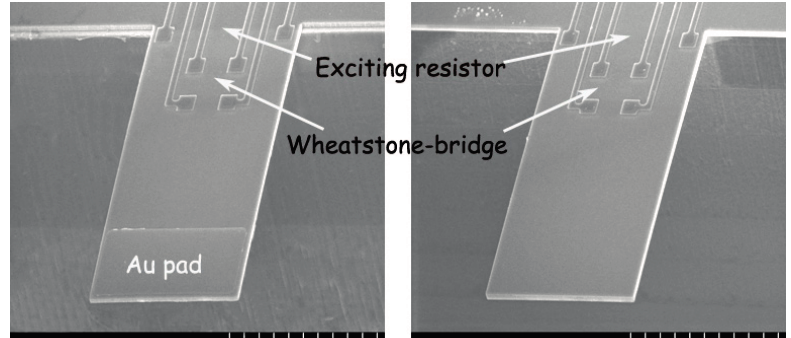
Figure 4. SEM images of the fabricated micro-cantilevers, with the optimally designed resonance exciting resistor and the signal-pickup piezoresistive Wheatstone-bridge integrated near the clamped root of the cantilever. The cantilever dimensions are 200 µm × 100 µm × 3 µm. Reprinted with permission from